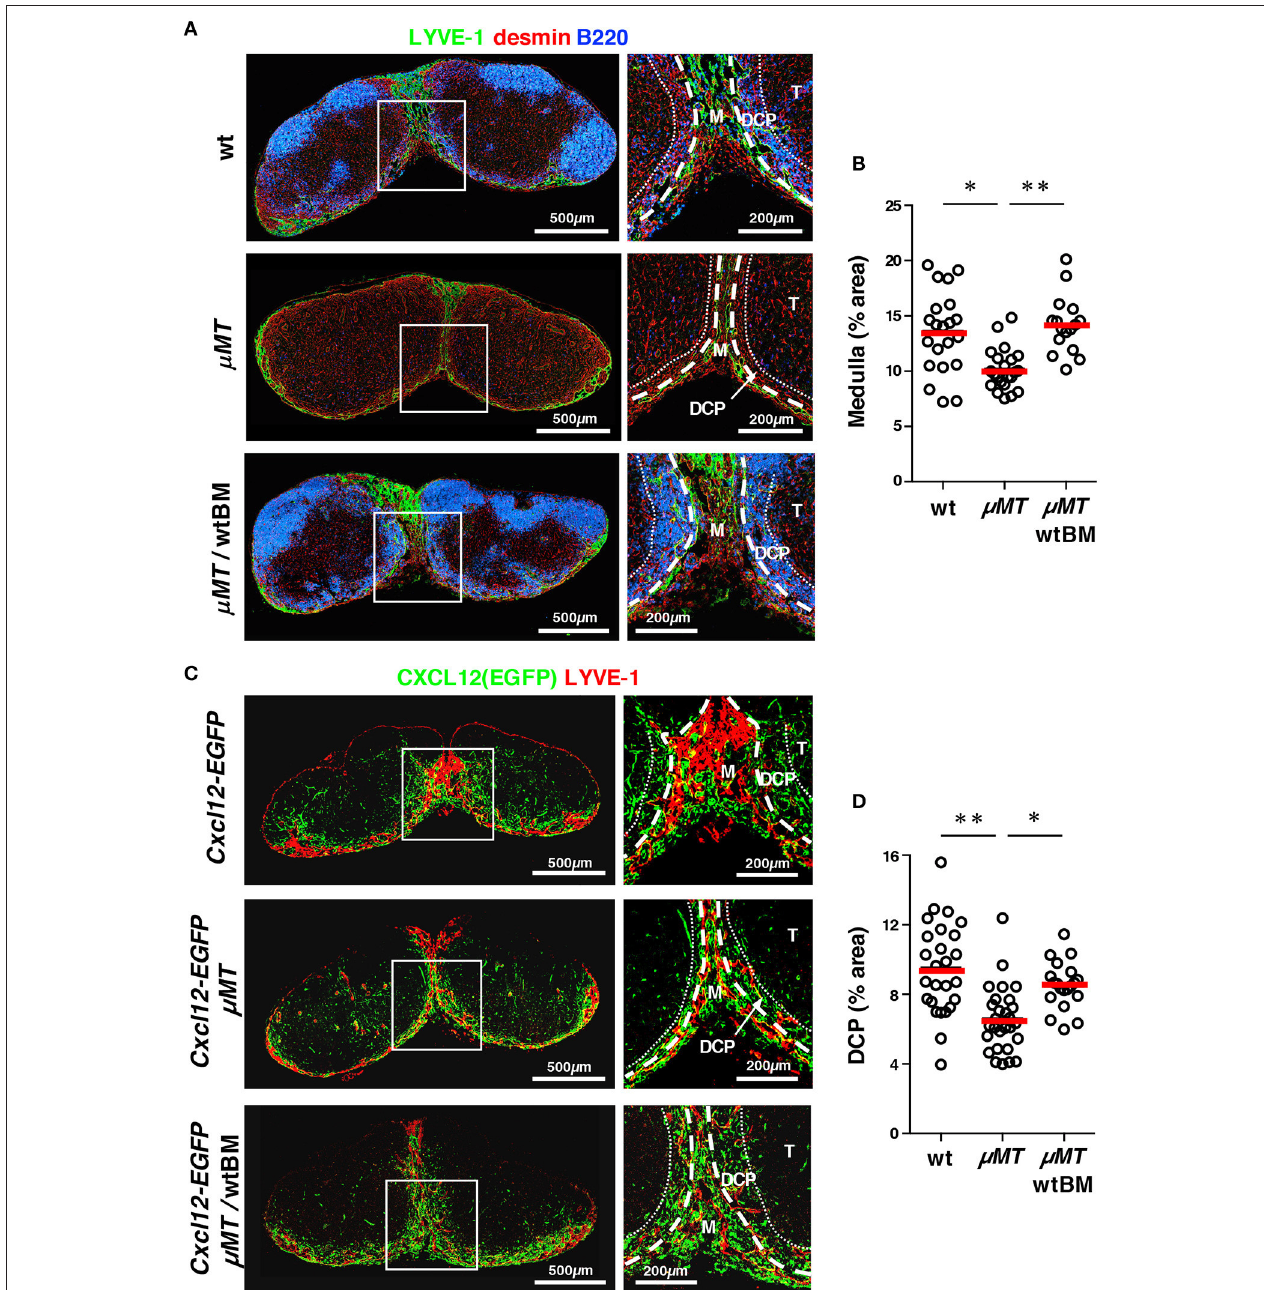
FIGURE 9 | B cells control the optimal development of the medulla and DCP in mouse LNs. (A) Development of the medulla was attenuated in the LNs of µ MT mice, which was restored with bone marrow transfer. Vertical sections of inguinal LNs isolated from wild type B6, µ MT mice, or µ MT mice reconstituted with wild type bone marrow (wtBM) were stained with antibodies against LYVE-1, desmin, and B220. Representative images are shown. Higher magnification view of the boxed region is shown in the right panel. (B) Proportion of medulla in the LNs (bars: mean; * p < 0.005). (C) The DCP was attenuated in Cxcl12 -EGFP/ µ MT mice LNs, which was restored with bone marrow transfer. Vertical sections of brachial LNs isolated from Cxcl12 -EGFP, Cxcl12 -EGFP/ µ MT mice, or Cxcl1 2-EGFP/ µ MT mice reconstituted with wild type bone marrow (wtBM) were stained with antibodies against LYVE-1, desmin, and B220. Higher magnification view of the boxed region is shown in the right panel. (D) Proportion of DCP in the LNs (bars: mean; * p < 0.005, ** p < 0.0001). number of corresponding FSC subsets. The differences in the the localization of a particular set of immune cells within the pattern of gene reporters and marker expression among FSCs territorialized network of the FSC subset. From this perspective, suggest their distinct roles in tissue organization and the LN has six major subcompartments and at least the same